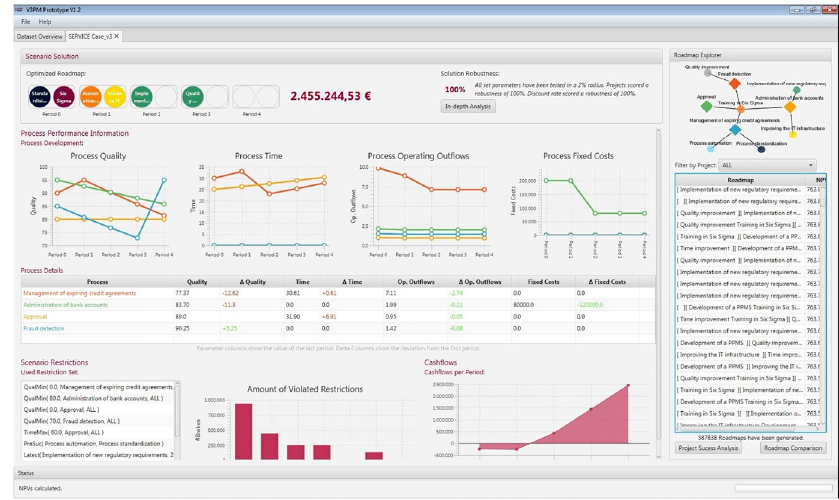
Fig. 4 Software prototype—scenario